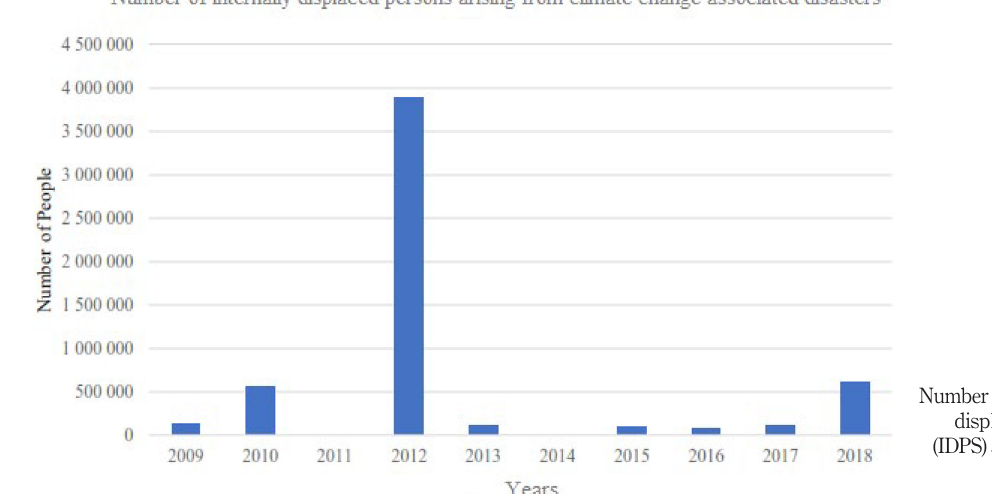
Figure 5. Number of internally displaced person (IDPS) arising from